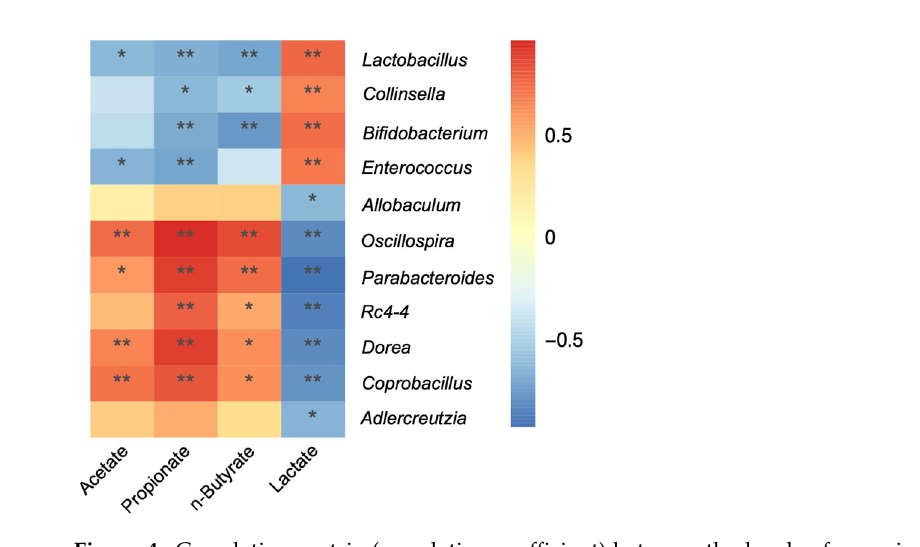
Figure 4. Correlation matrix (correlation coefficient) between the levels of organic acids and the relative abundances of genera. * p < 0.05, ** p < 0.01.